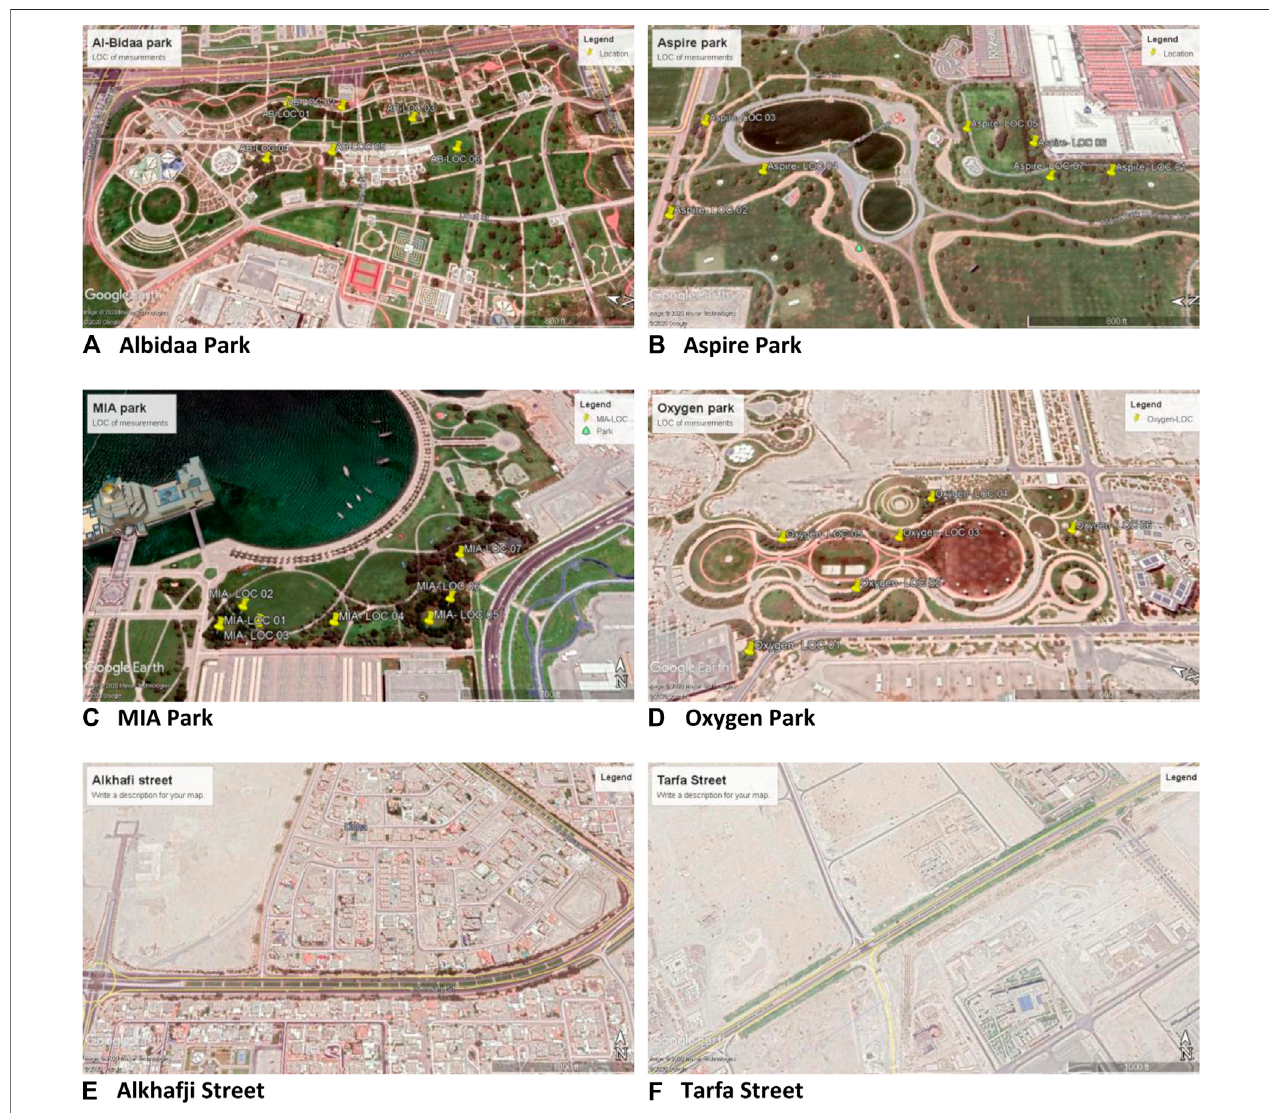
FIGURE 3 | Locations assigned for the selected land-use